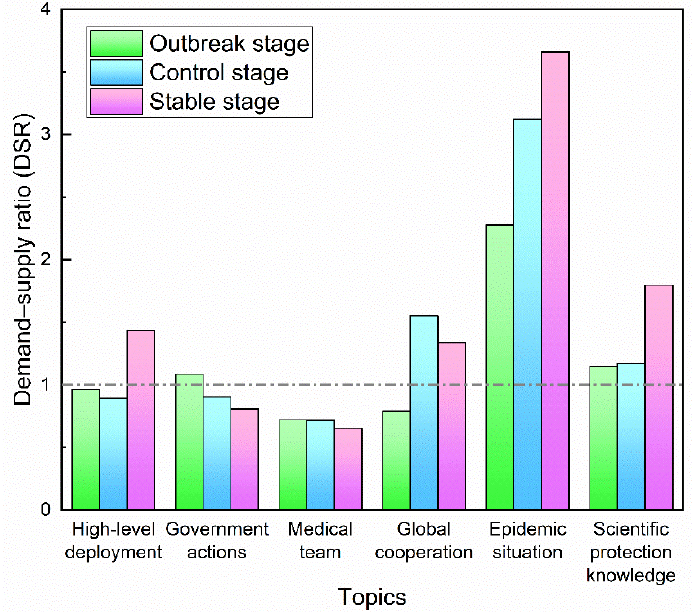
Figure 15. DSR on different topics at different stages.